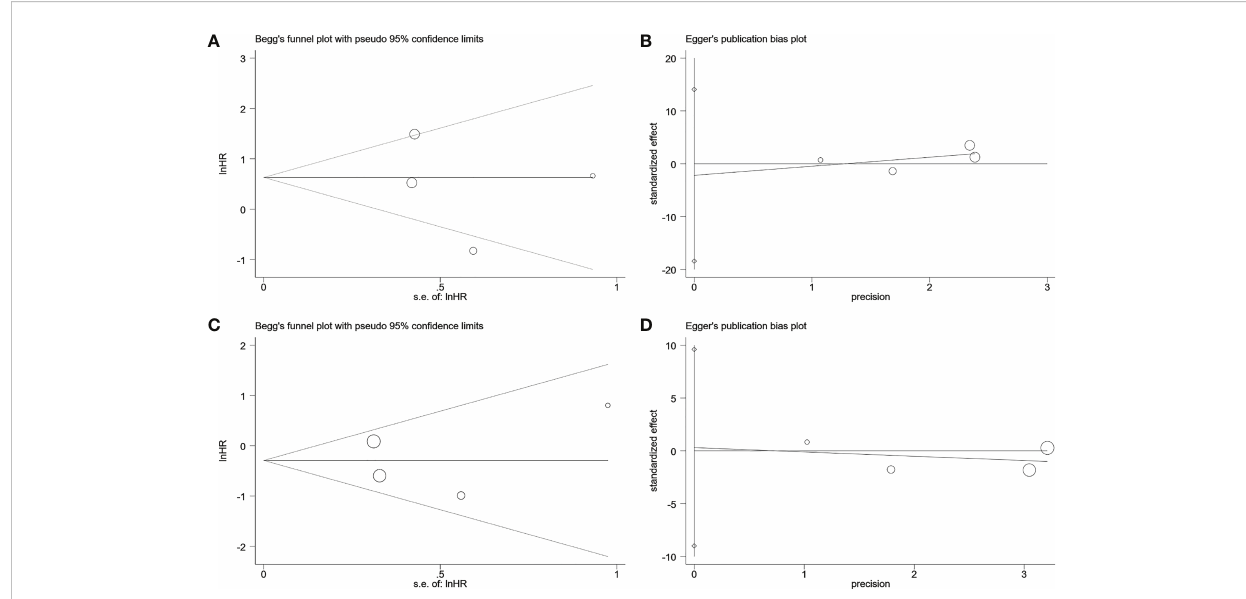
FIGURE 5 Begg ’ s test and egger ’ s test to detect publication bias. (A) Begg ’ s publication bias plot of DFS/RFS. (B) egger ’ s publication bias plot of DFS/RFS. (C) Begg ’ s publication bias plot of OS. (D) egger ’ s publication bias plot of OS. DFS, disease-free survival; RFS, relapse-free survival; OS, overall survival.